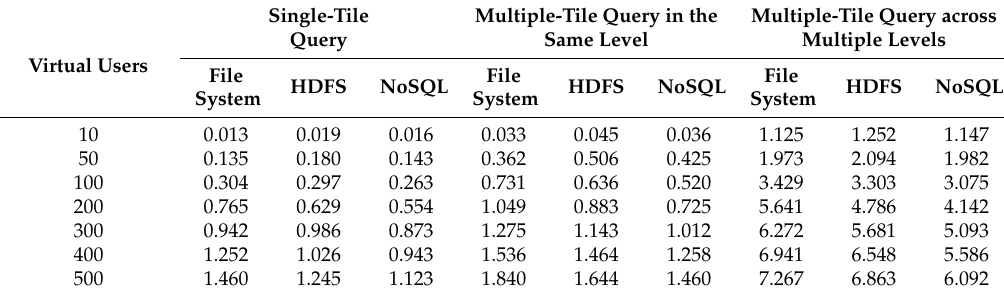
Table 2. Average response time of three concurrent access patterns